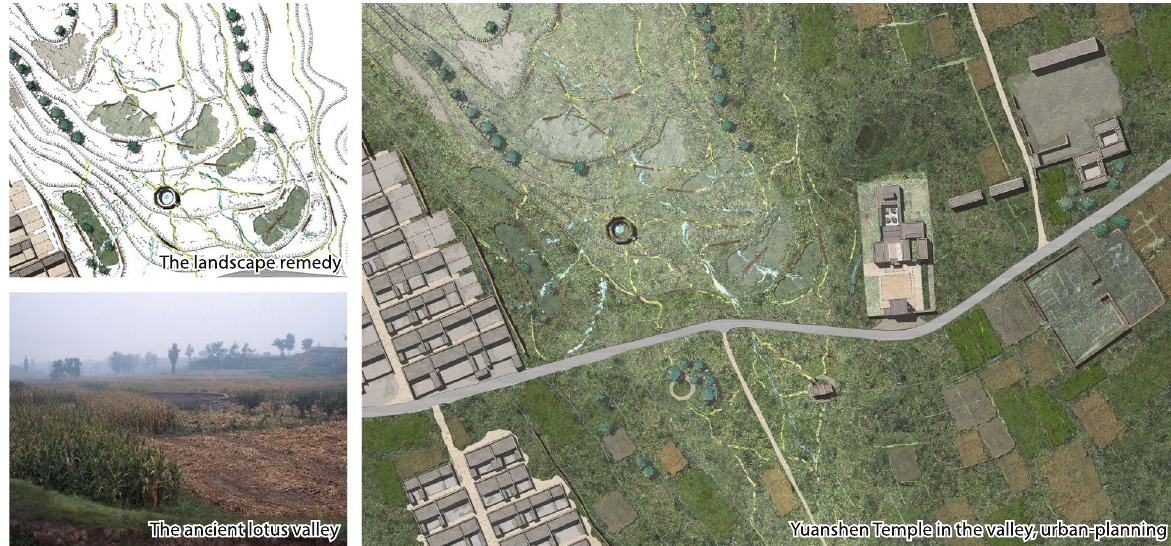
Fig. 20 Landscape restoration (Source: Tongji University and Ecole de Chaillot